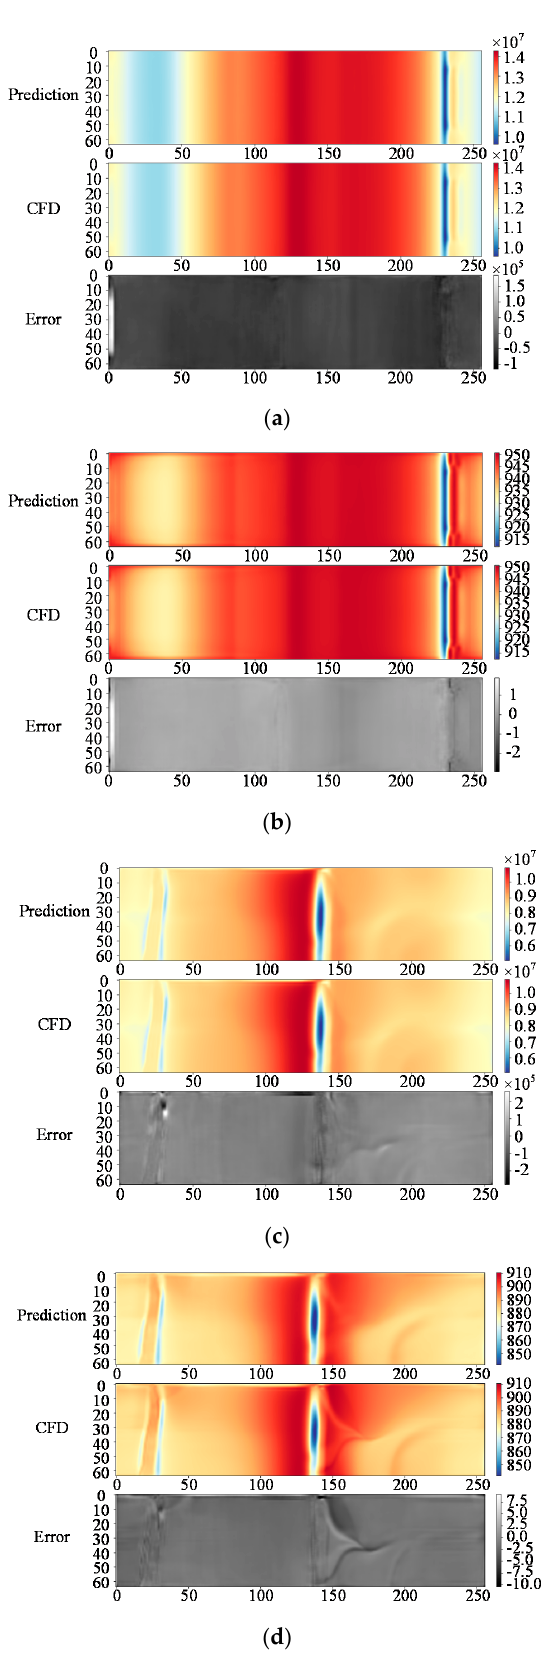
Figure 11. The parameter distribution of Case A: ( a ) the pressure of the stator blade; ( b ) the temperature of the stator blade; ( c ) the pressure of the rotor blade; ( d ) the temperature of the rotor